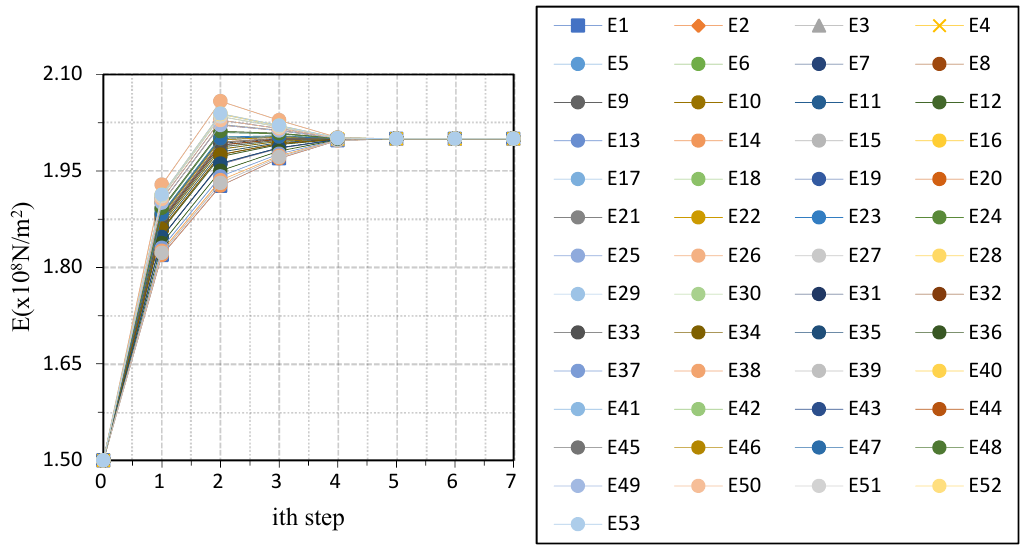
Figure 5. Calculation results under 53 unknowns.